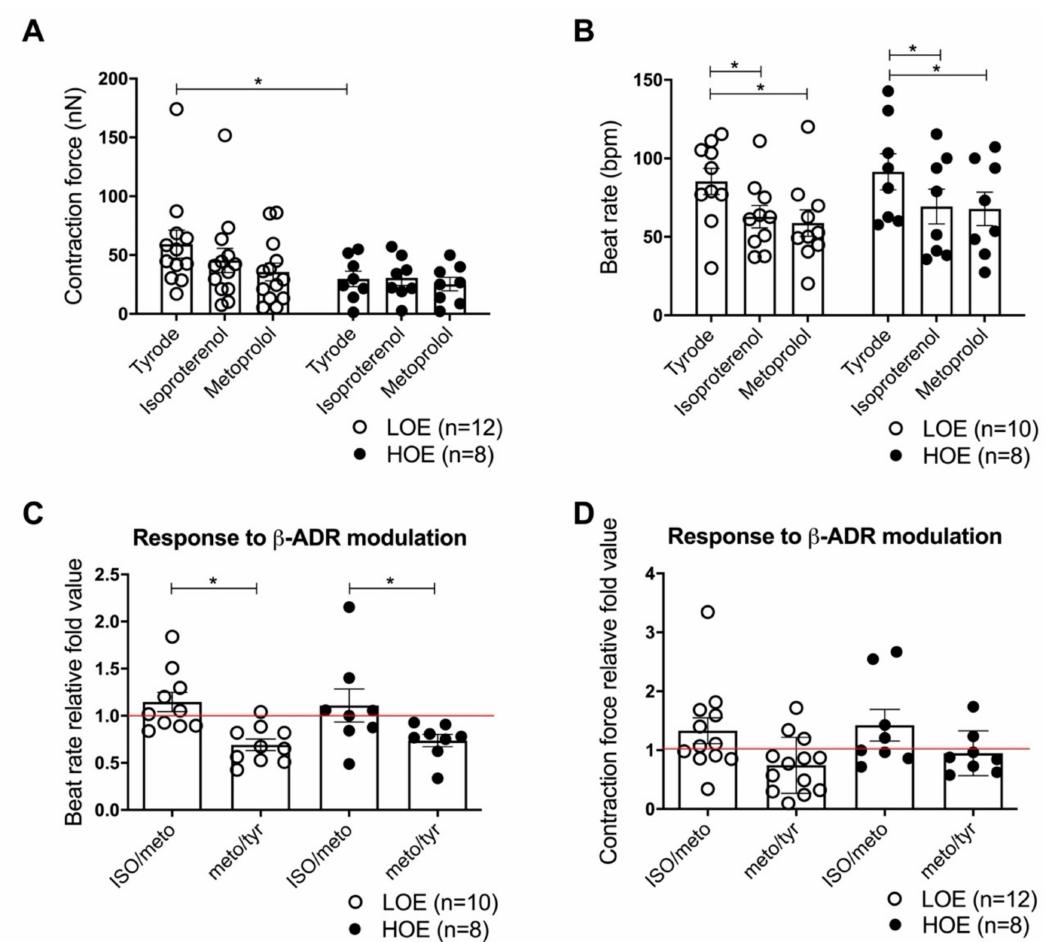
Figure 7. 3D cardiac spheroids differentiate under LOE show greater contraction force. Mechanical analysis of contraction force (in nN) and beat rate (in beats/minute, bpm) has been performed using AFM mechanograms in a single position in 3D cardiac spheroids (using hiPSC UEFhfiPS1.4 and hESC CCTL12 lines) differentiated under LOE (white dot plots) and HOE (black dot plots) conditions. ( A ) Contraction force (nN) in 3D cardiac spheroids differentiated under LOE and HOE conditions. ( B ) Beat rate (bpm) in 3D cardiac spheroids differentiated under LOE and HOE conditions. ( C ) Relative analysis of β -adrenergic modulation for beating rate in 3D cardiac spheroids differentiated under LOE and HOE conditions. ( D )